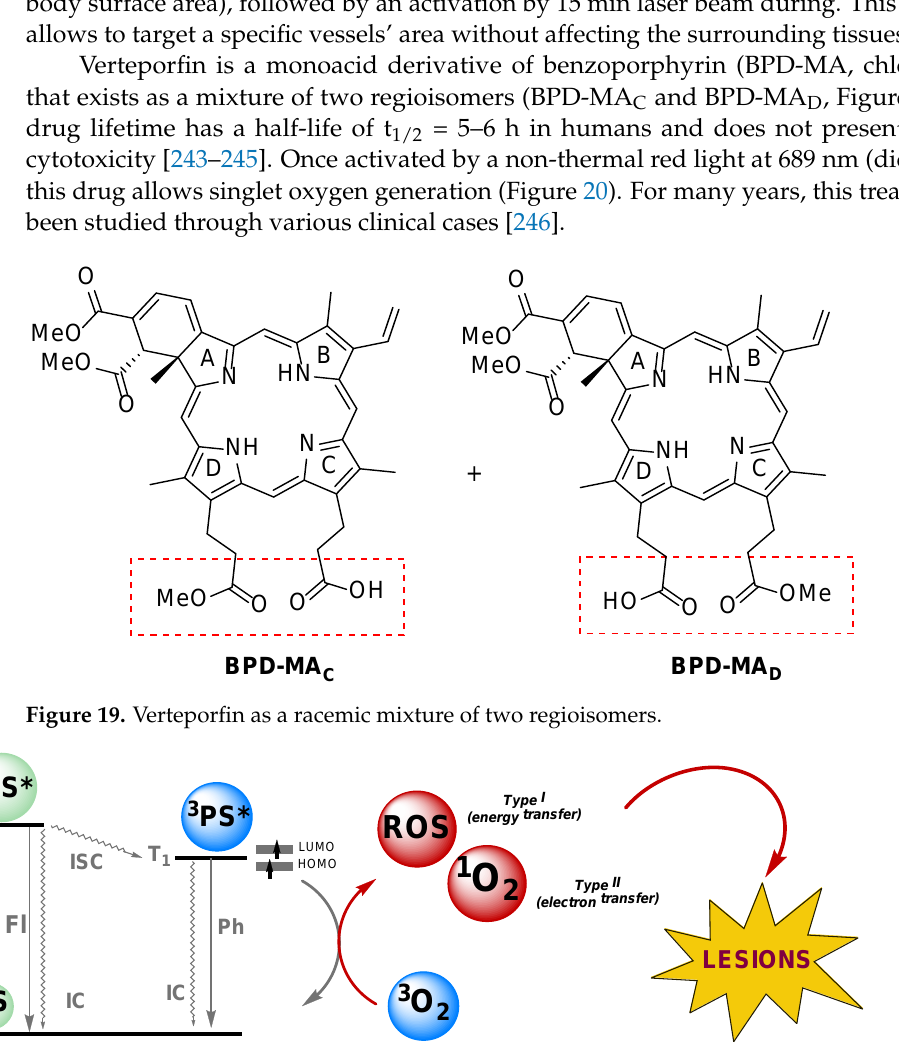
Figure 20. Principle of PDT: simplified Jablonski diagram. Photochemical mechanisms of ROS generation (type I, electron transfer and type II, energy transfer) in the presence of molecular oxygen ( 3 O 2 ) upon excitation of a photosensitizer (PS). S 0 : singlet ground state; S 1 : singlet excited state; T 1 : triplet excited state; Abs: absorption; Fl: fluorescence; Ph: phosphorescence; IC: internal conversion; ISC: intersystem crossing; *: Excited state.